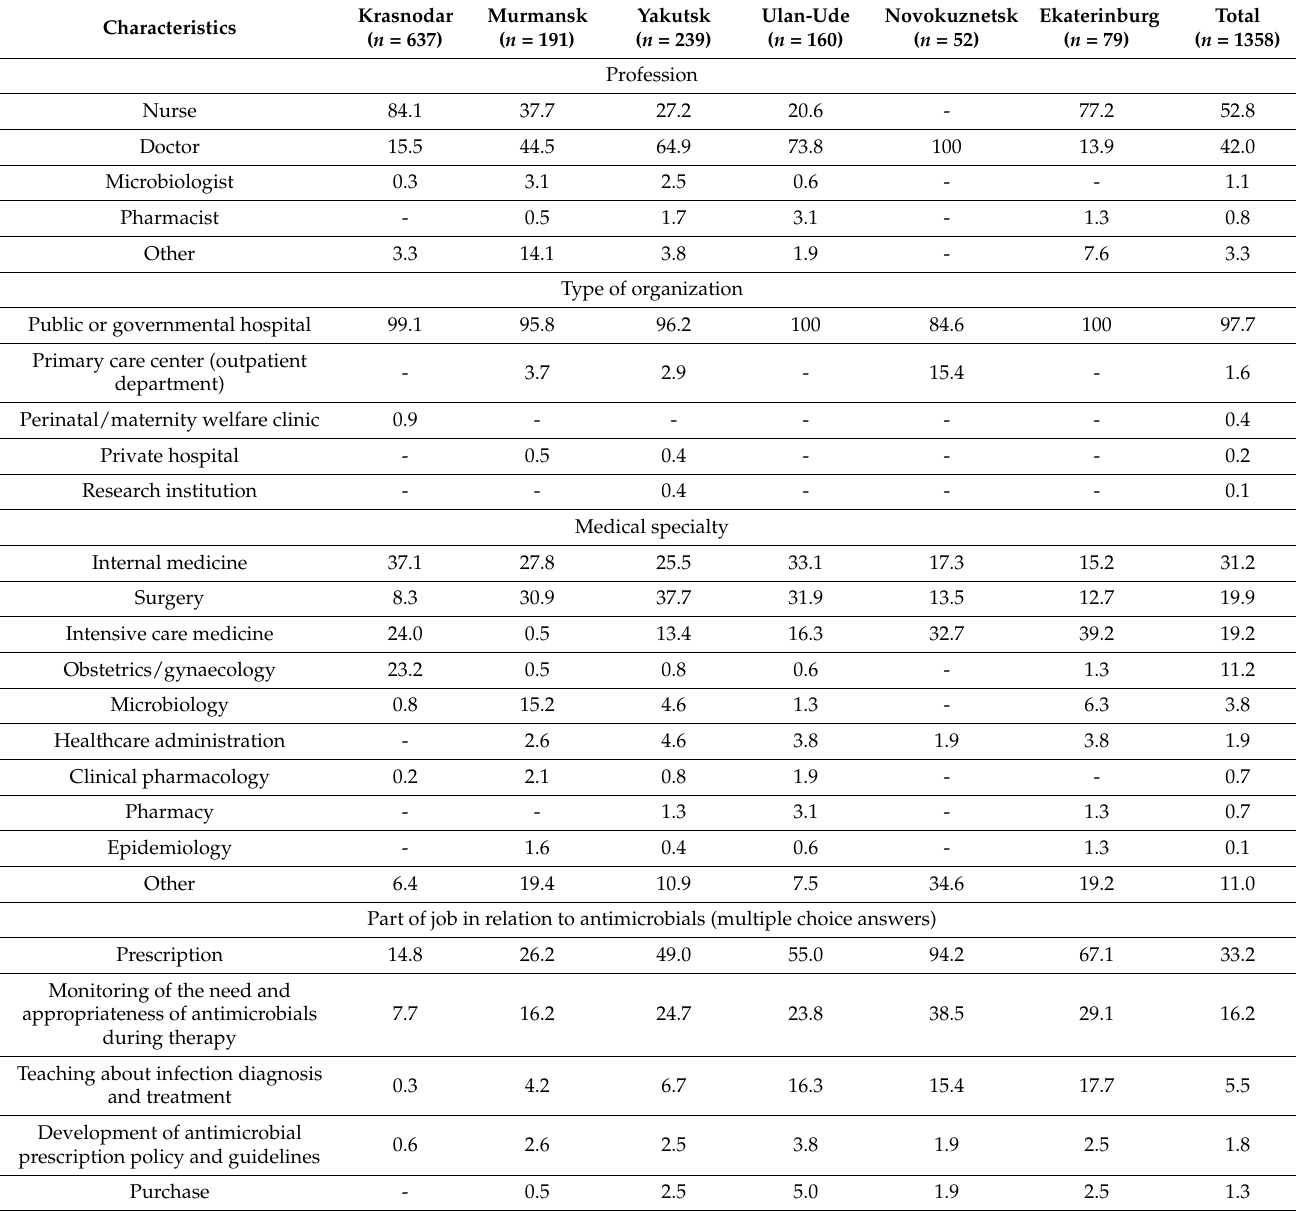
Table 2. Main characteristics of survey respondents,